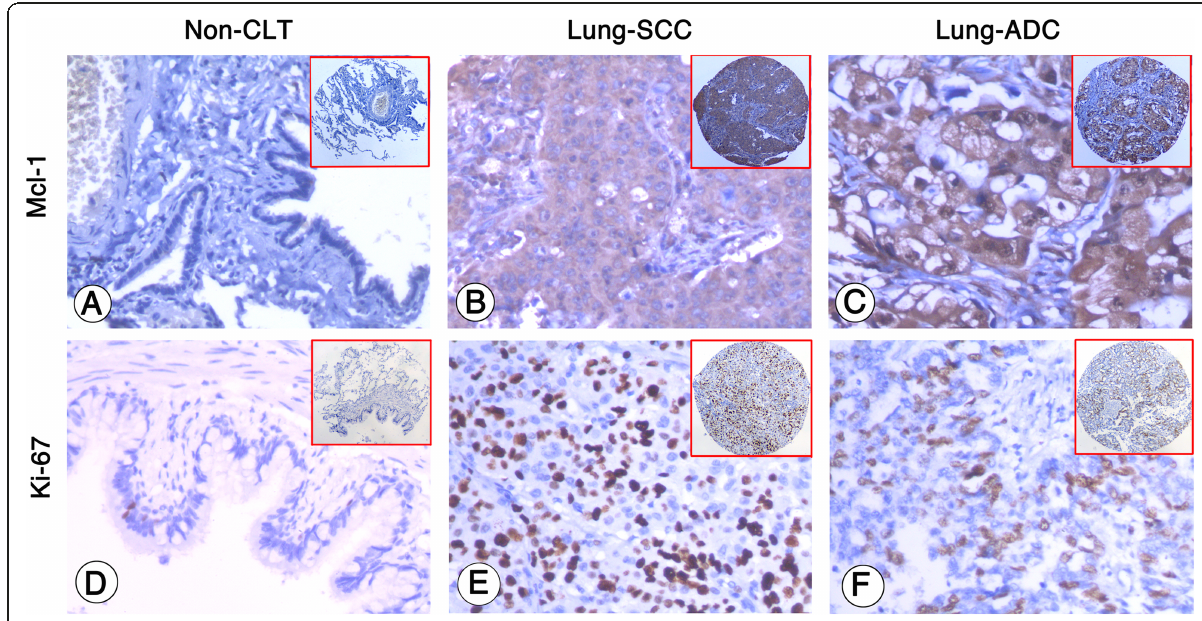
Fig. 1 Mcl-1 expression and Ki-67 PI in non-cancerous lung tissues (non-CLT), lung SCC cells and lung ADC cells were detected by IHC using specific antibody as described in the section of materials and methods. Negative staining of Mcl-1 and low PI were showed in non-CLT ( a and d , 200×, IHC, DAB staining). Strong positive staining of Mcl-1 was found in cell cytoplasm of lung SCC and lung ADC cells ( b and c , 200×, IHC, DAB staining), and high PI was found in the nucleus of lung SCC and lung ADC cells ( e and f , 200×, IHC, DAB